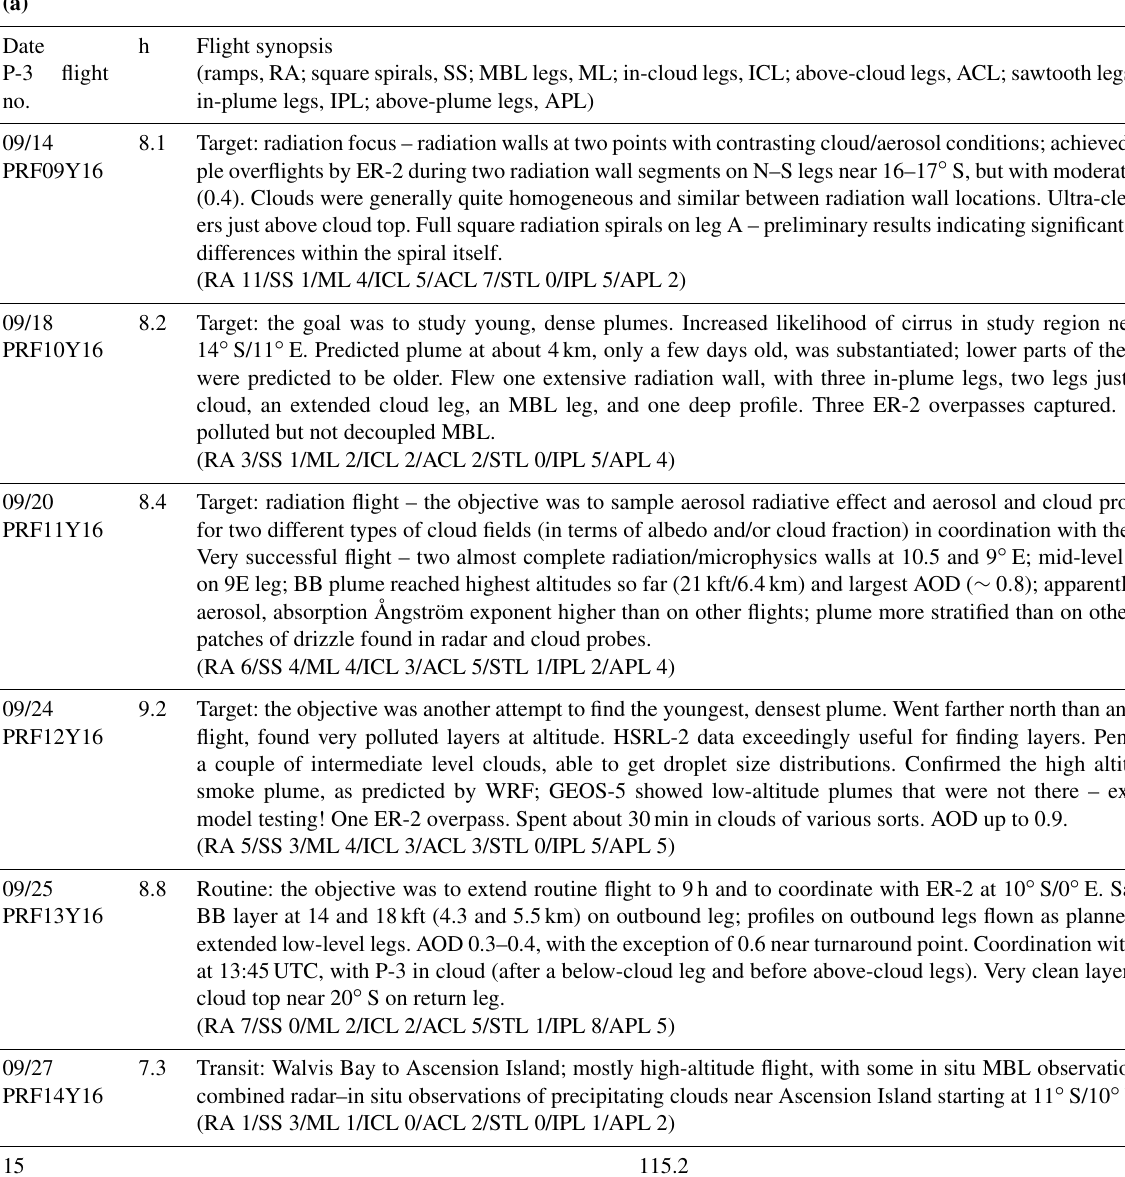
(ramps, RA; square spirals, SS; MBL legs, ML; in-cloud legs, ICL; above-cloud legs, ACL; sawtooth legs, STL; Target: radiation focus – radiation walls at two points with contrasting cloud/aerosol conditions; achieved multi- ple overflights by ER-2 during two radiation wall segments on N–S legs near 16–17 ◦ S, but with moderate AOD (0.4). Clouds were generally quite homogeneous and similar between radiation wall locations. Ultra-clean lay- ers just above cloud top. Full square radiation spirals on leg A – preliminary results indicating significant albedo differences within the spiral itself. 8.2 Target: the goal was to study young, dense plumes. Increased likelihood of cirrus in study region near 12– 14 ◦ S/11 ◦ E. Predicted plume at about 4km, only a few days old, was substantiated; lower parts of the plume were predicted to be older. Flew one extensive radiation wall, with three in-plume legs, two legs just above cloud, an extended cloud leg, an MBL leg, and one deep profile. Three ER-2 overpasses captured. Mostly polluted but not decoupled MBL. Target: radiation flight – the objective was to sample aerosol radiative effect and aerosol and cloud properties for two different types of cloud fields (in terms of albedo and/or cloud fraction) in coordination with the ER-2. Very successful flight – two almost complete radiation/microphysics walls at 10.5 and 9 ◦ E; mid-level clouds on 9E leg; BB plume reached highest altitudes so far (21kft/6.4km) and largest AOD ( ∼ 0 . 8); apparently fresh aerosol, absorption Ångström exponent higher than on other flights; plume more stratified than on other days; patches of drizzle found in radar and cloud probes. Target: the objective was another attempt to find the youngest, densest plume. Went farther north than any other flight, found very polluted layers at altitude. HSRL-2 data exceedingly useful for finding layers. Penetrated a couple of intermediate level clouds, able to get droplet size distributions. Confirmed the high altitude of smoke plume, as predicted by WRF; GEOS-5 showed low-altitude plumes that were not there – excellent model testing! One ER-2 overpass. Spent about 30min in clouds of various sorts. AOD up to 0.9. Routine: the objective was to extend routine flight to 9h and to coordinate with ER-2 at 10 ◦ S/0 ◦ E. Sampled BB layer at 14 and 18kft (4.3 and 5.5km) on outbound leg; profiles on outbound legs flown as planned, with extended low-level legs. AOD 0.3–0.4, with the exception of 0.6 near turnaround point. Coordination with ER-2 at 13:45UTC, with P-3 in cloud (after a below-cloud leg and before above-cloud legs). Very clean layer above cloud top near 20 ◦ S on return leg. Transit: Walvis Bay to Ascension Island; mostly high-altitude flight, with some in situ MBL observations and combined radar–in situ observations of precipitating clouds near Ascension Island starting at 11 ◦ S/10 ◦